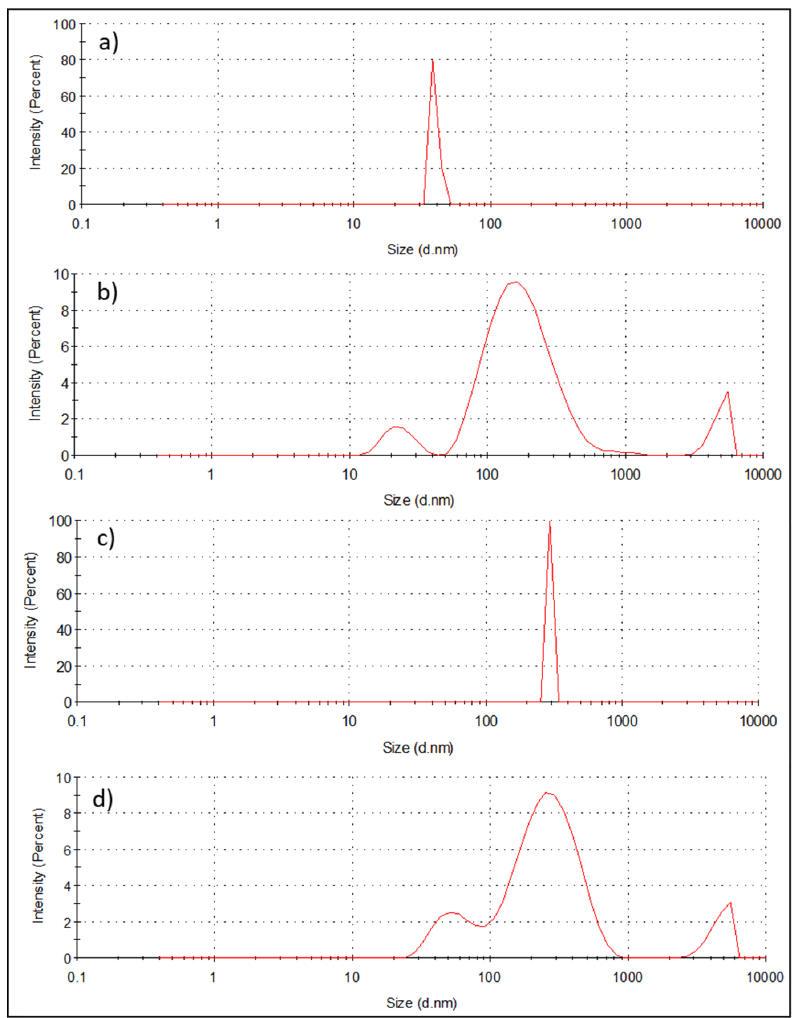
Figure 5. The particle size distribution measured using Dynamic Light Scattering (DLS) of ( a ) synthesized Fe, ( b ) Ag/Fe ( c ), APTES–Ag/Fe, and ( d ) PEI–Ag/Fe.